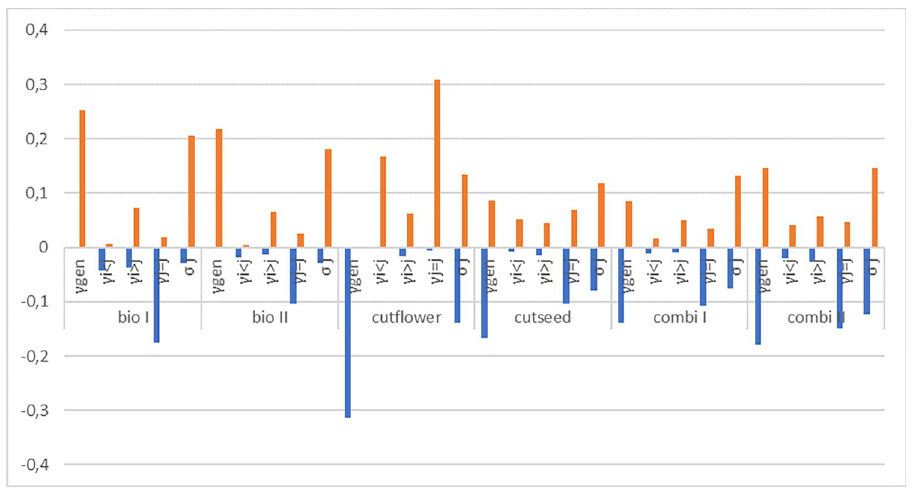
Fig 6. Contribution of vital rates to the difference in population growth rate ( Δλ ) between the control and other treatments (bio I, biodiversity 1 ; bio II, biodiversity 2 ; cutflower, flower cut treatment; combi I, combination treatment 1; combi II, combination 2; cutseed, seed cut treatment) in the pooled J . vulgaris population, as determined by LTRE (life-table response experiment) analysis. Bar sections above zero display the summed positive contributions (orange) and bar sections below zero the summed negative contributions (blue).